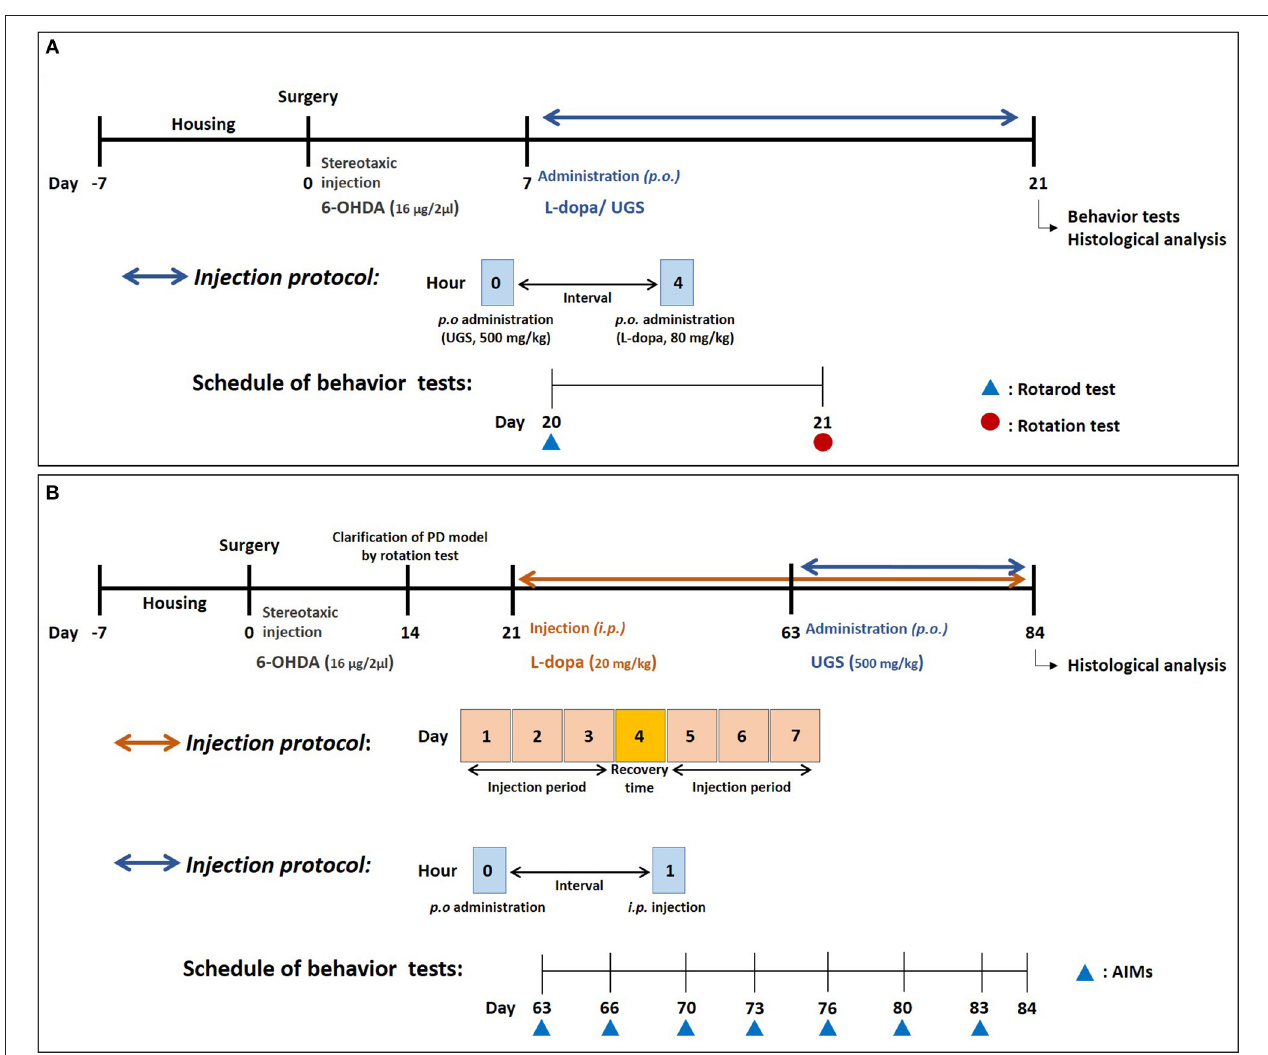
FIGURE 1 | Experimental schedule. The schedule for investigating the effects of UGS and L-dopa on motor dysfunctions (A) and for the effects of UGS on LID (B)